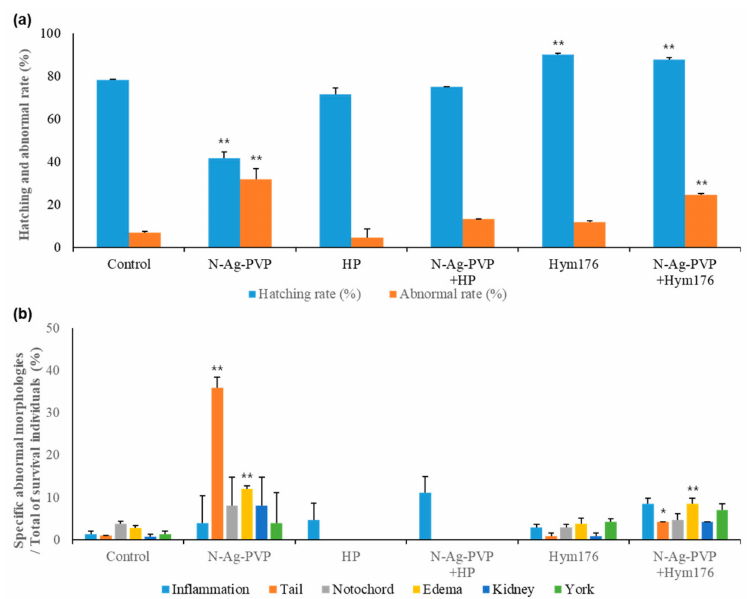
Figure 1. The e ff ects of N-Ag-PVP, HP, N-Ag-PVP + HP, Hym176, and N-Ag-PVP + Hym176 on the hatching and abnormal rate ( a ) and rates of specific abnormal morphologies among surviving embryos ( b ). All measurements are reported as the group mean of three replicates and the standard deviation (n = 60). * comparison of experimental groups to a homogeneous subset of post-hoc test results ( p < 0.05), ** comparison of experimental groups to a homogeneous subset of post-hoc test results ( p <